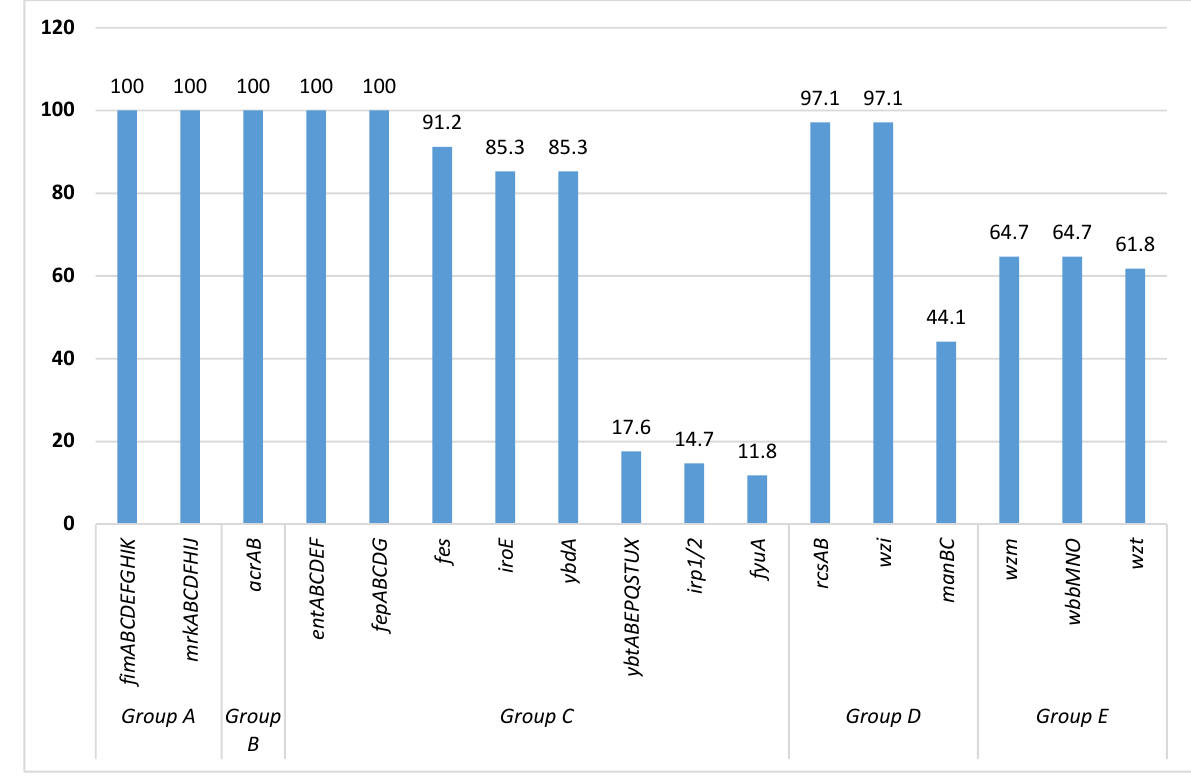
Figure 1. Percentages of virulence genes found in sequenced Klebsiella pneumoniae .